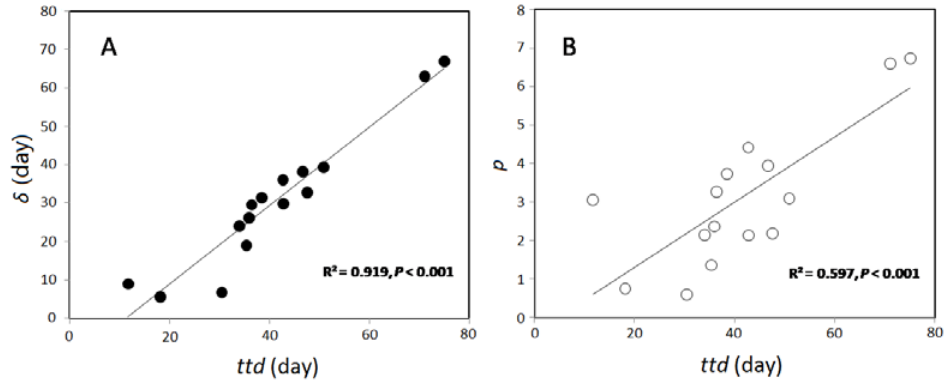
Figure 6. Correlation of survival time ( ttd ) with ( A ) first decimal reduction time ( δ ) and ( B ) the shape parameter ( p ).